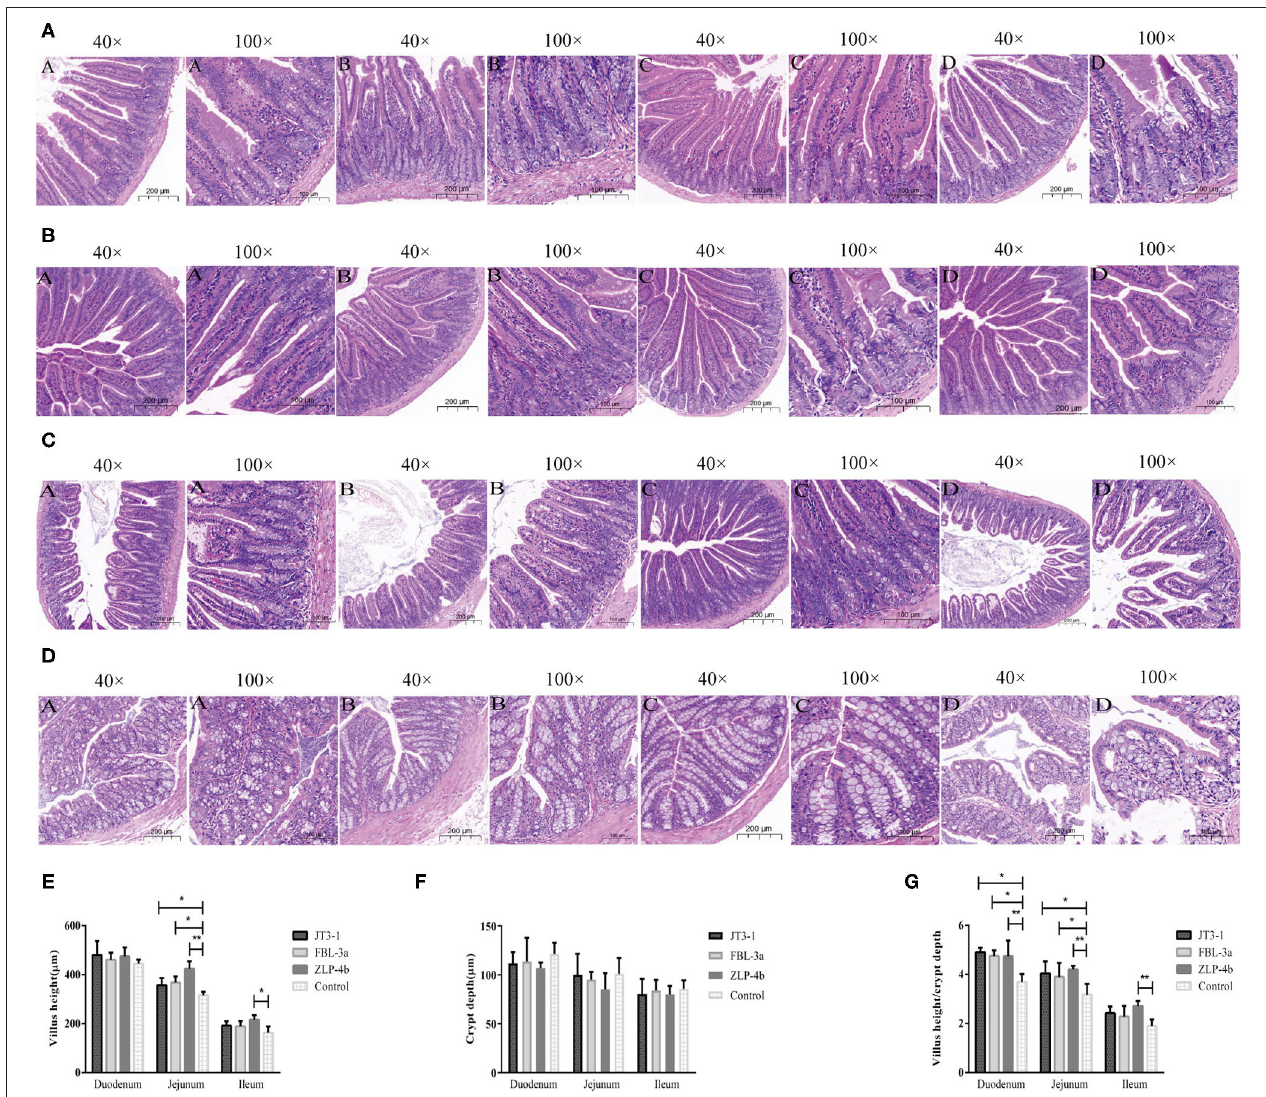
FIGURE 2 | The effects of probiotic pretreatment on the epithelial mucosa integrity of the intestine of mice. (A–D) Intestinal morphology shown by hematoxylin and eosin staining of the duodenum, jejunum, ileum, and colon tissues of mice. The images of intestinal morphology at × 40 and × 100 magnification are shown, respectively. (E) Statistical analysis of villus height ( µ m), (F) crypt depth ( µ m), and (G) the ratios of villus height ( µ m) to crypt depth ( µ m) in the duodenum, jejunum, and ileum of mice, respectively. (A) JT3-1 group, (B) FBL-3a group, (C) ZLP-4b group, and (D) control group. * P < 0.05; ** P <